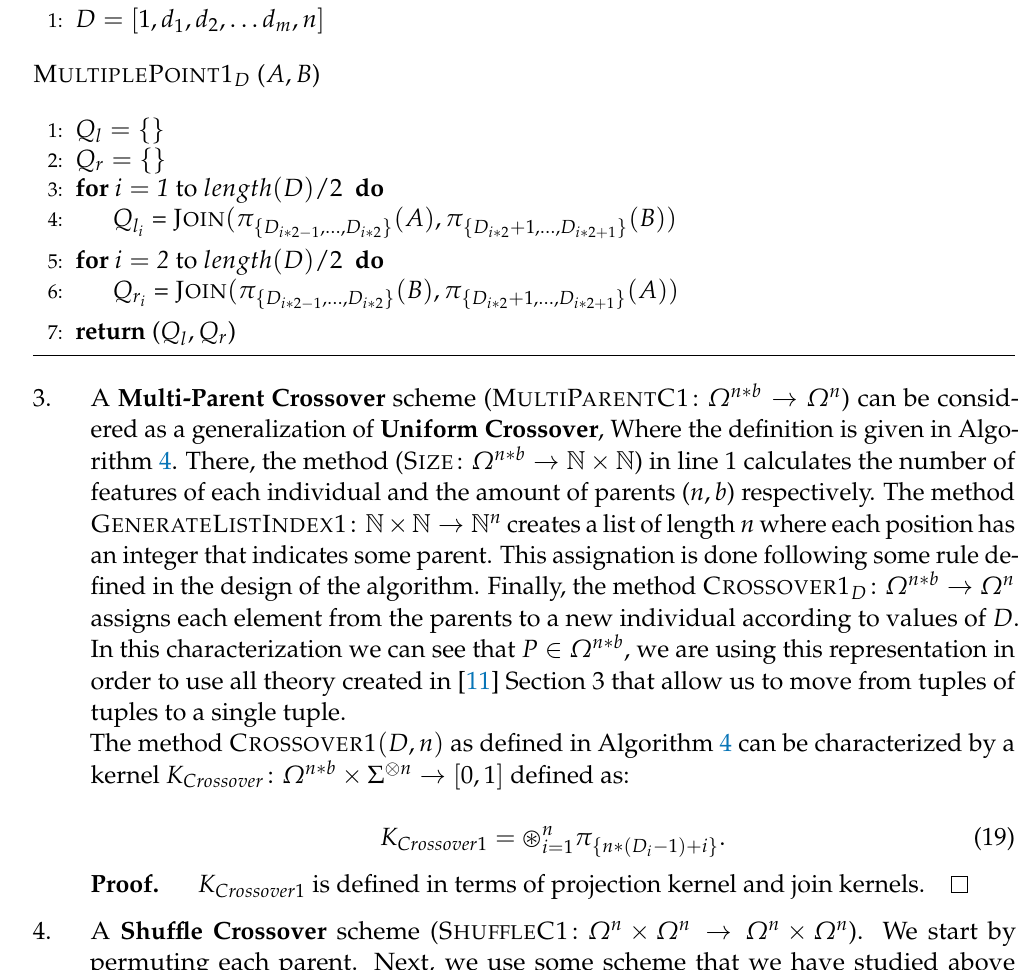
Algorithm 3 Multiple Point Crossover-M ULTIPLE P OINT